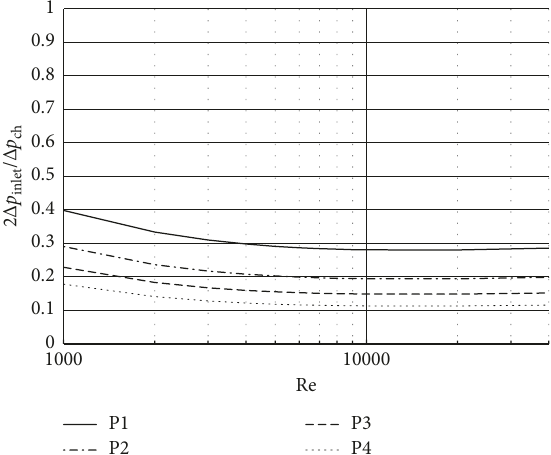
Re for plates P1–P4 for HL ( )